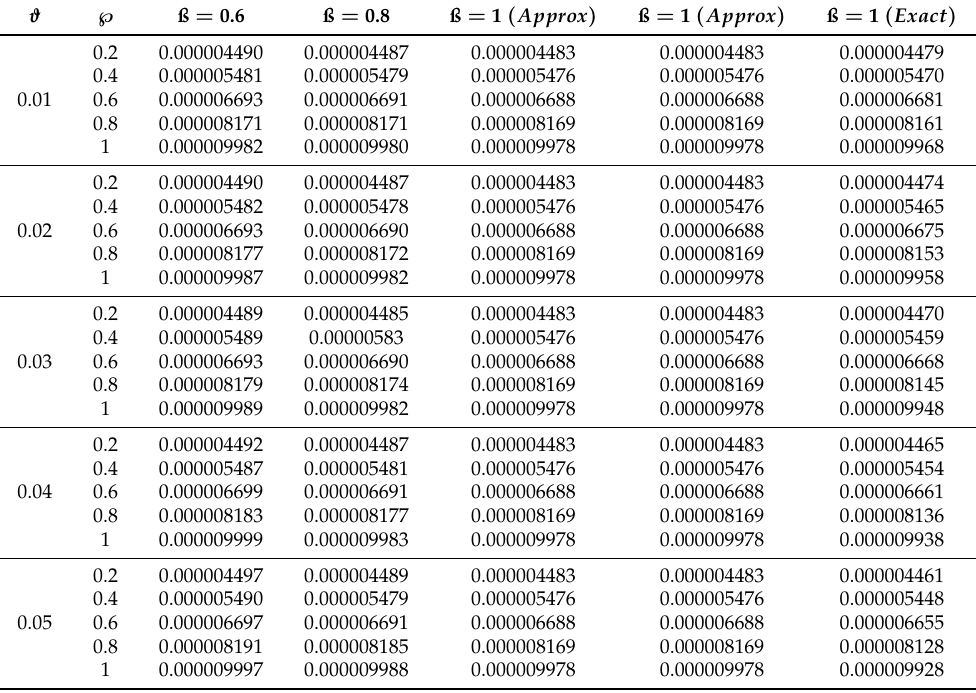
Figure 2. The solutions for the V ( ℘ , ϑ ) surface with regard to ℘ and ϑ are explored for various values of ß. ( a ) The surface solution of the function V ( ℘ , ϑ ) at the values of ß = 0.25, ( b ) ß = 0.50, ( c ) ß = 0.75, and ( d ) ß = 1. Table 1. The exact ETDM and HPTM results of V ( ℘ , ϑ ) for problem 1 at various fractional orders of ß having different values of ℘ and ϑ